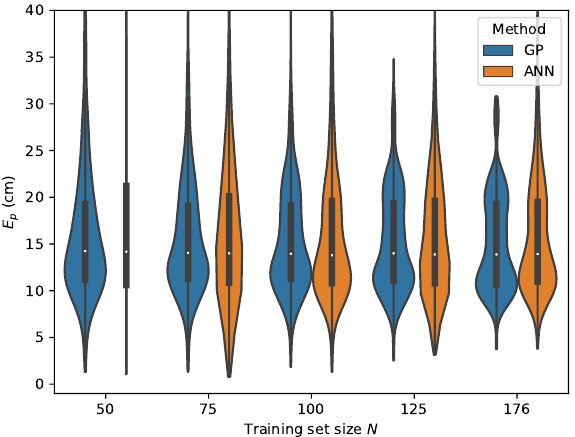
Figure 18. Cross-validation with set E where the r rel , max input features are used.